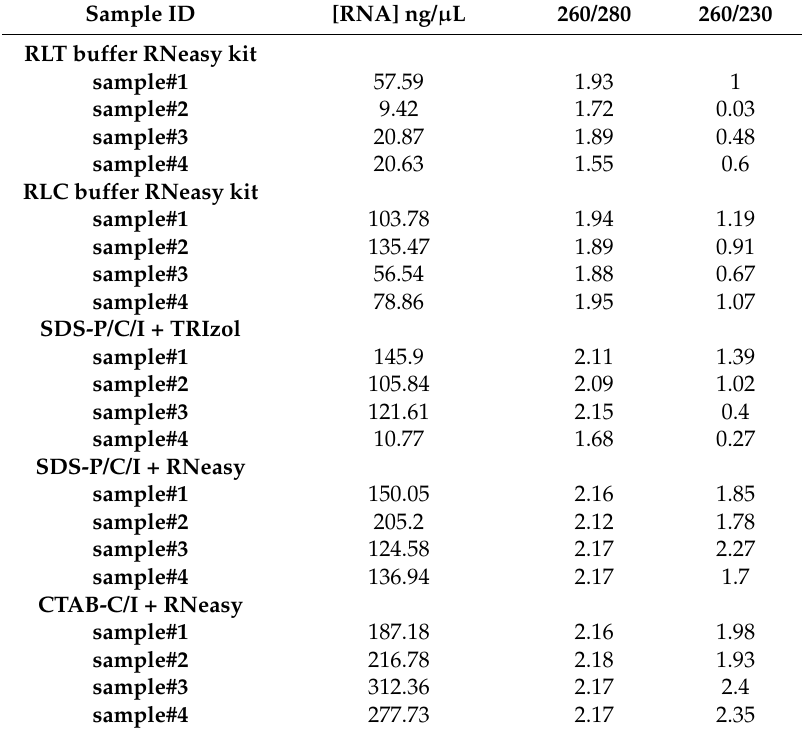
Table 1. Summary of the parameters (yield and purity measured at the NanoDrop) of the RNA extracted with the four different